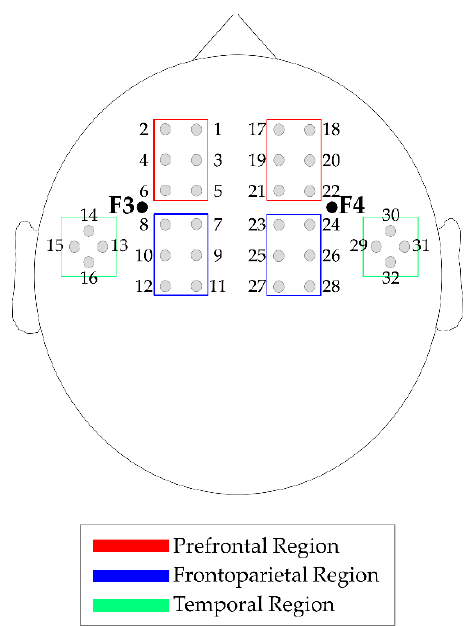
Figure 2. fNIRS channels and region of interest (ROI) map. Note: Sources and detectors are localized on a 10–20 system. Left-prefrontal ROI: Channels 1–6. Left-frontoparietal ROI: Channels 7–12. Right-prefrontal ROI: Channels 17–22. Right-frontoparietal ROI: Channels 23-28. Temporal areas were not considered in the analyses.